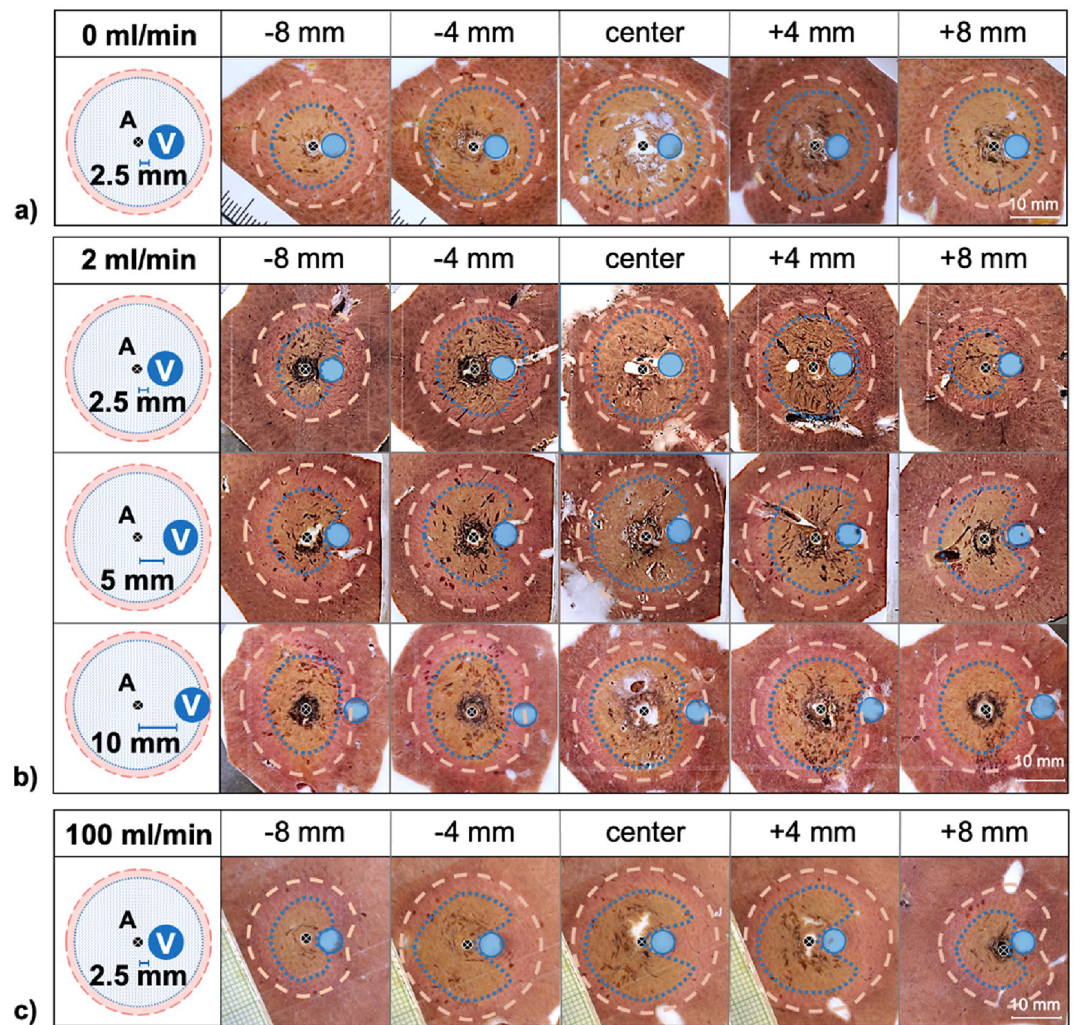
Figure 1. Example cross sections of ablations with a perfusion rate of 0 ml/min ( a ), 2 ml/min ( b ) and 100 ml/ min ( c ). The ablation centre as well as cross sections of the ablation periphery (± 4 mm and ± 8 mm) are shown. The typical ablation zones [inner WZ (blue dotted), outer RZ (white dashed)] could be observed in all test series. No change in ablation shape of the WZ could be observed in the ablation centre at an A–V distance of 2.5 mm at a flow rate of 2 ml/min. Relevant cooling effects occurred only at a higher flow rate of 100 ml/min at an A–V distance of 2.5 ml/min ( c ). All other cross sections showed indentations of the clinically relevant WZ around the cooling vessels (V) at higher A–V distances of 5.0 and 10.0 mm independent of the flow